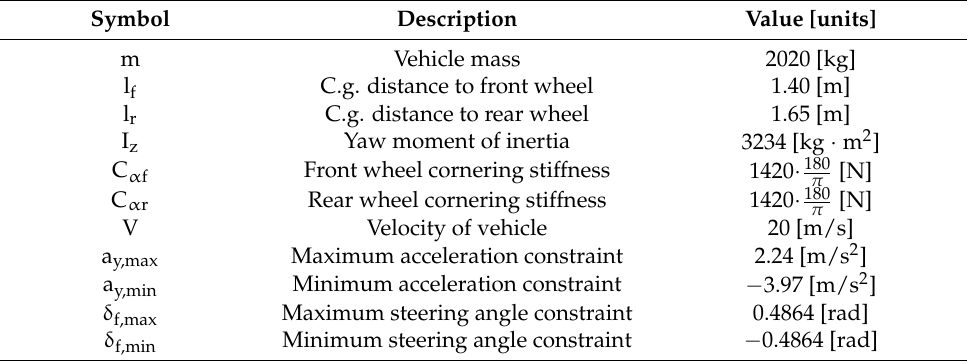
Table 1. MPC parameters.